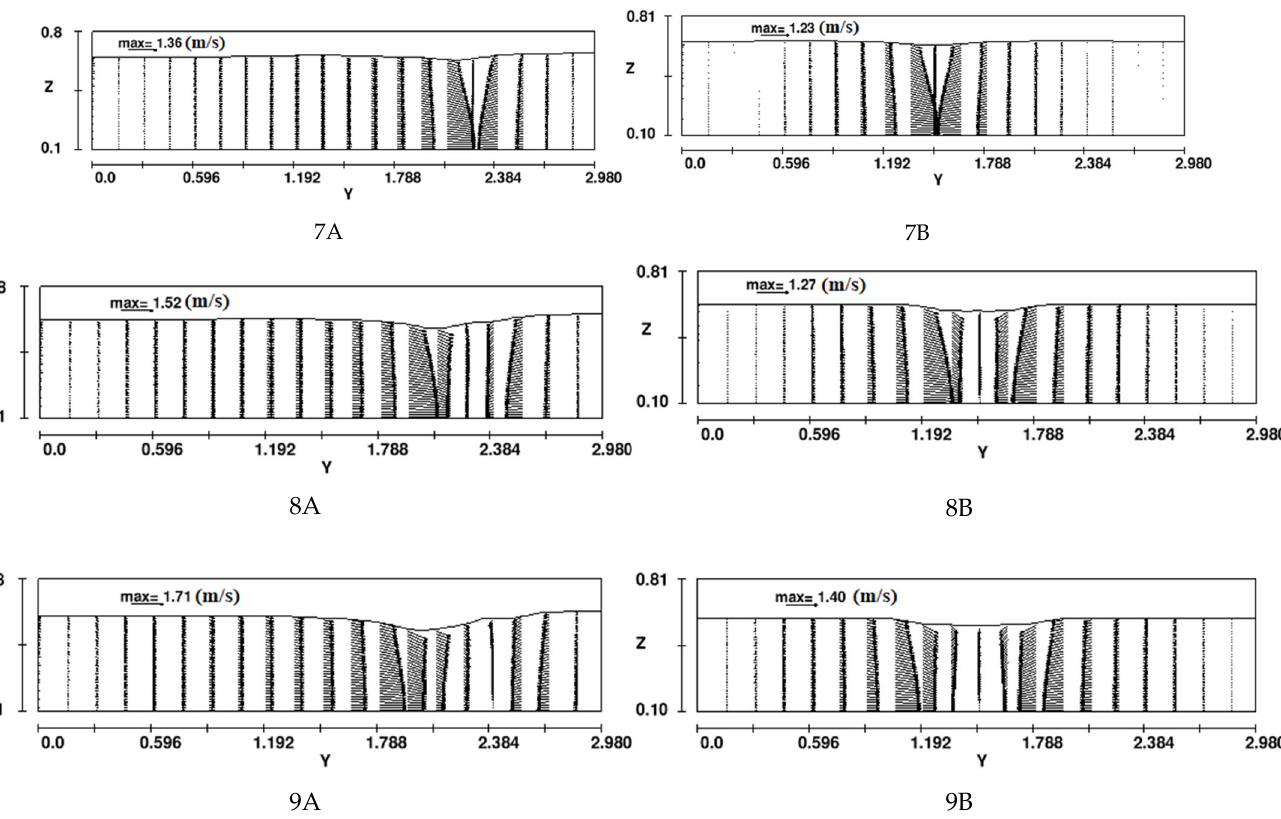
Figure 9. Water depth profiles at the center of dam gate. Solid line: cases 7A, 8A, 9A; dot line: cases 7B, 8B, 9B. Besides temporal variation of near–bed velocity, components u and w at the center of the outlet do not depend on the dam gate’s position, (Figure 10). In x direction, gate width b = 25 cm generates the maximum horizontal u velocity of 2 m/s, while the larger breach sizes, 50 cm and 75 cm, produce smaller values. Vertical component w is negative and nearly dismissed in all simulated times. This point is different with [ Error! Reference source not found. ] when 4 breach sizes showed both negative and positive values of w . The reason may be due to the small ratio range b/B , from 0.08 to 0.25, in comparison with the larger range of (0.3 ÷ 1.0) in the aforementioned work. Additionally, transverse velocity v approximately equals zero when the reservoir’s mouth is symmetrical, while the harmonic trend of this value is seen in models 7A, 8A and 9A.